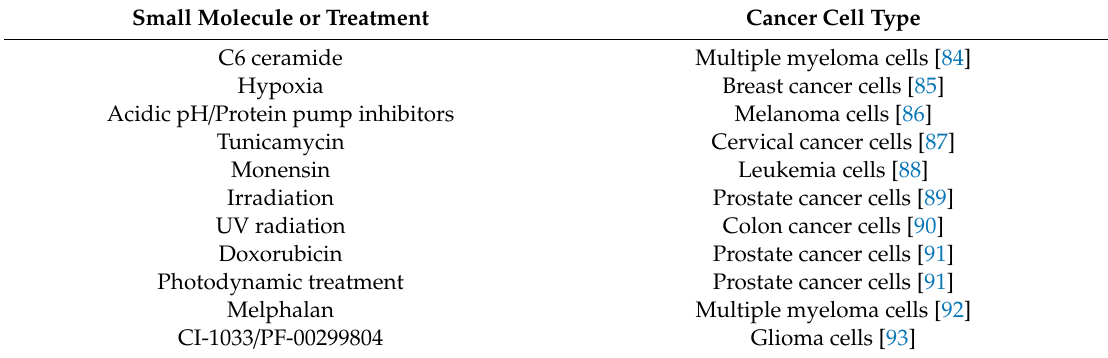
Table 3. List of small molecules and treatments that a ff ect exosome release.